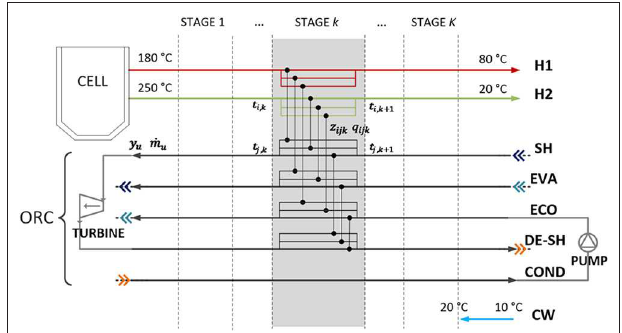
FIGURE 5 | Scheme of the combined HEN + ORC superstructure for techno-economic optimization. Hot and cold streams are represented with arrows pointing respectively to the right and to the left. In temperature stage k , all the possible heat exchangers between hot stream i and cold stream j in stage k , that can be selected with binary variables ( z ijk ), are represented with black vertical connectors. In addition, each ORC stream u is characterized by variable mass flow rate ˙ m u and a binary variable for its selection y u